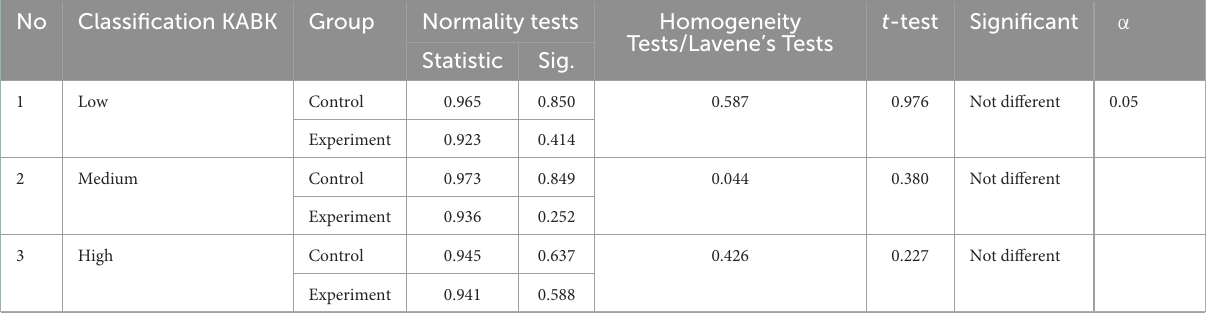
TABLE 3 Classification of basic abilities of the students’ critical thinking.